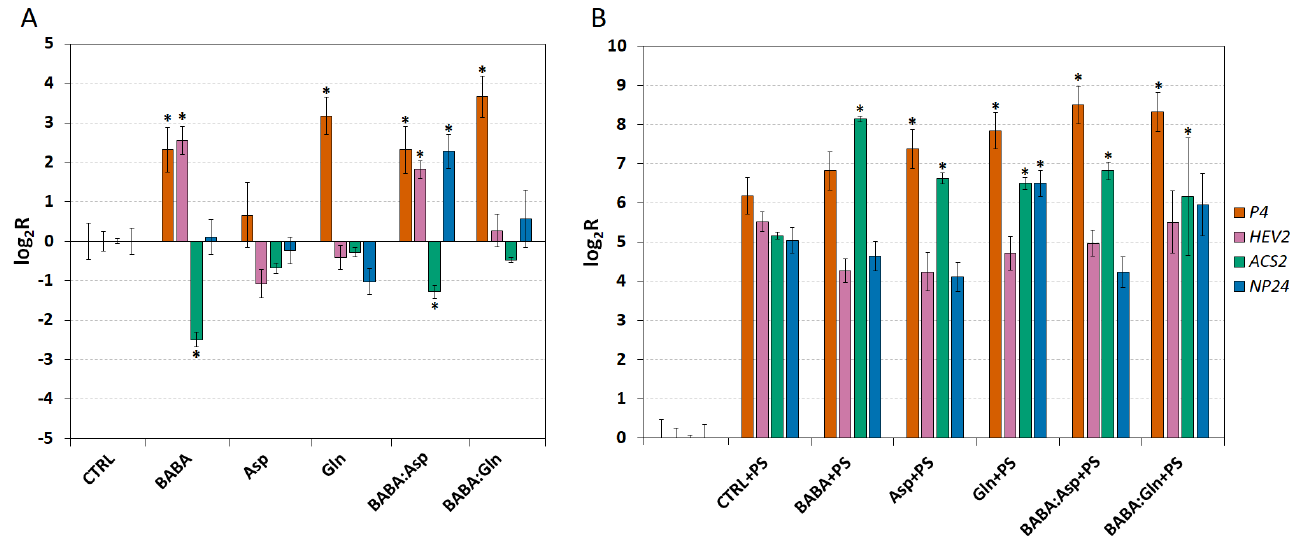
Figure 3. The expression of defence genes in Solanum lycopersicum cv. Amateur plants. The transcript levels of four defence genes ( P4, HEV2, ACS2 and NP24 ) were monitored in 8-week-old leaflets (n = 6) 24 h after treatment with 5 mM BABA and/or amino acids solutions (BABA, L-Asp, BABA:Asp, L-Gln, BABA:Gln) ( A ) or 48 h after their inoculation with P. syringae pv. tomato DC3000 ( B ). Transcript levels were measured by the RT-qPCR method and evaluated by the ΔΔCt method [14]. The control tissue (CTRL) was a water-treated control sample. Each bar represents the mean ± SE. Asterisks denote mean values that differ significantly from that of the control tissue based on Dunnett’s test (* p < 0.05).